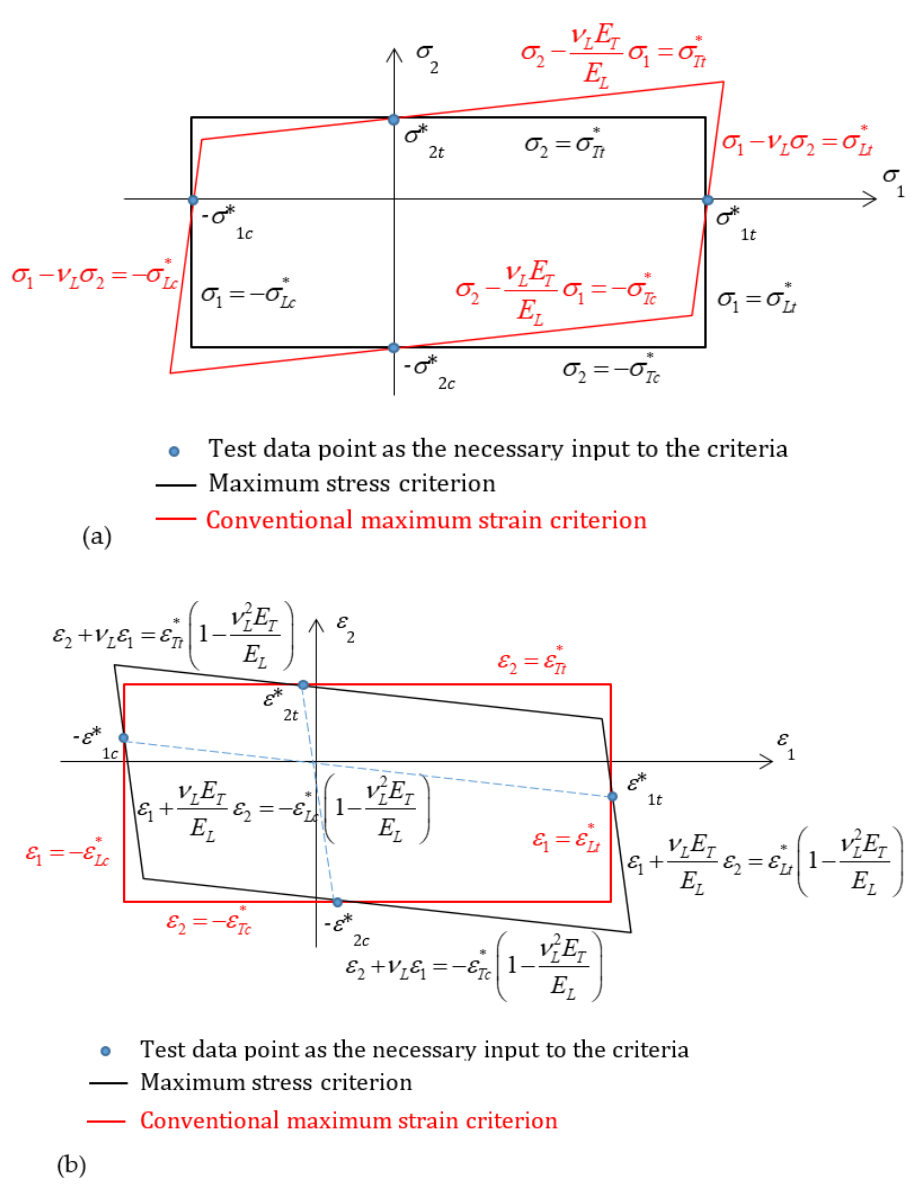
Figure 1. Failure envelopes from the maximum stress / strain criteria ( a ) in the stress plane and ( b ) in the strain plane.